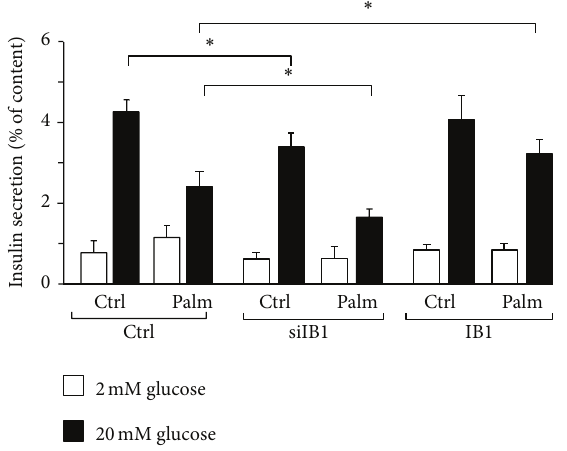
Figure 5: Role of Ib1 in impaired glucose-induced insulin secretion caused by palmitate. For measurement of insulin secretion, MIN6 cells were transiently transfected with the control siRNA ( open bar ) or siIB1 ( filled bar ) or the plasmids coding for the wild type HA- tagged IB1 (IB1). 48 hrs after transfection, insulin secretion was stimulated by preincubating the cells for 30 min in Krebs-Ringer buffer containing 2 mmol/L glucose and, thereafter, incubating the cells with glucose 20 mmol/L. The amounts of insulin release and cellular contents during the incubation period were measured by EIA. The results are expressed as the ratio between the amounts of insulin released over the content and are the mean ± SEM of three independent